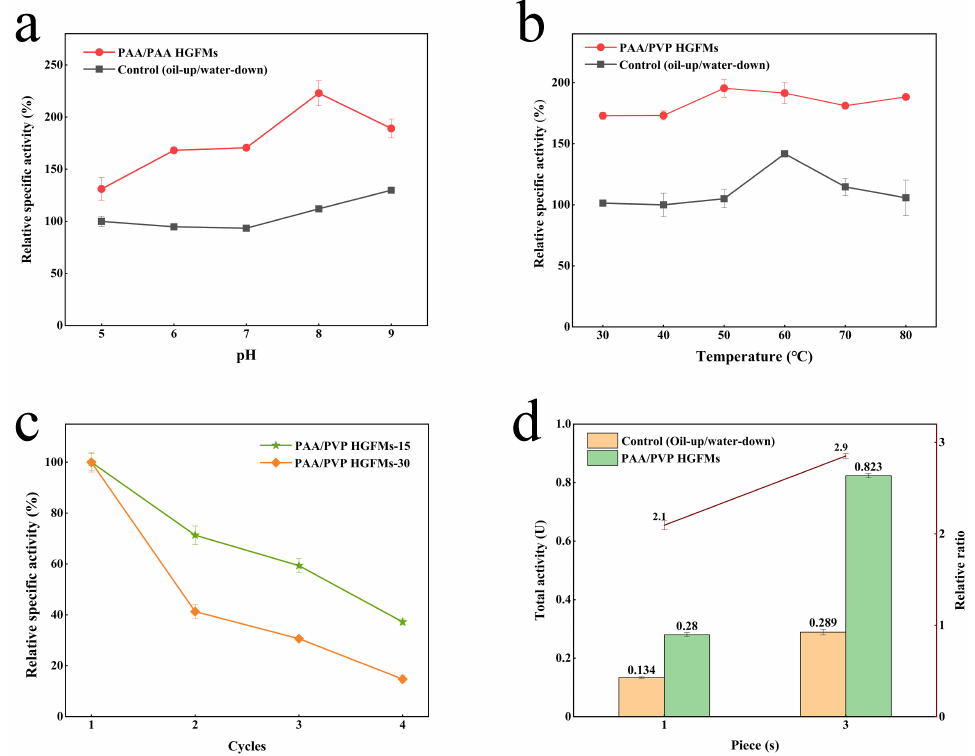
Figure 8. Application performance of the PAA/PVP HGFMs at different pH ( a ), temperatures ( b ), numbers of cycles for different reaction times ( c ) and different numbers of membrane pieces assembled in the reactors ( d ). All the HGFMs were prepared using an electrospinning speed ratio of PAA/PVP of 5/8, an electrospinning time of 8 h, a thermal crosslinking time of 45 min, and a UV crosslinking time of 15